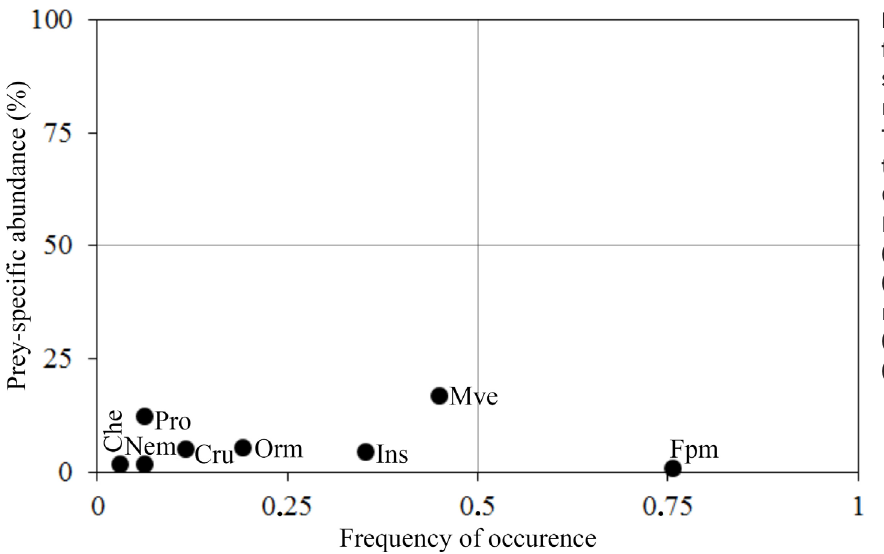
Figure 4. Feeding strategy for population of L. anus studied in the Chasqueiro reservoir, southern